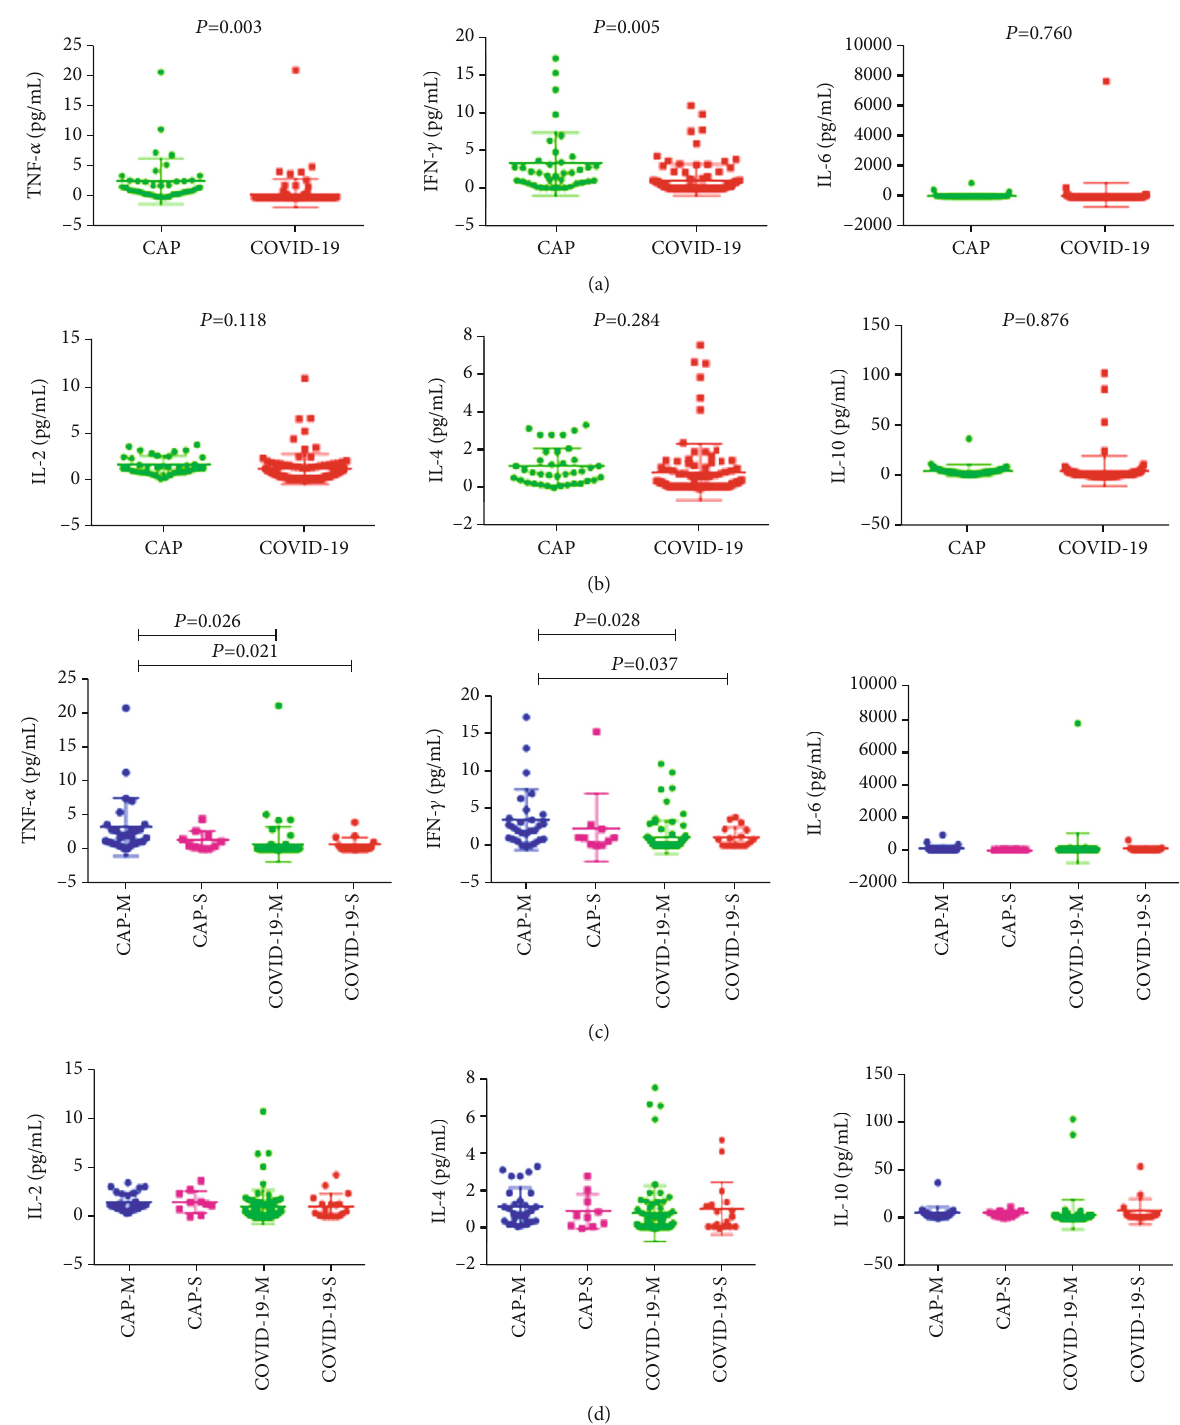
Figure 4: General characteristics of cytokines in patients with mild CAP (CAP-M), severe CAP (CAP-S), mild COVID-19 (COVID-19-M), and severe COVID-19 (COVID-19-S). ∗ p < 0 : 05 , ∗∗ p < 0 : 01